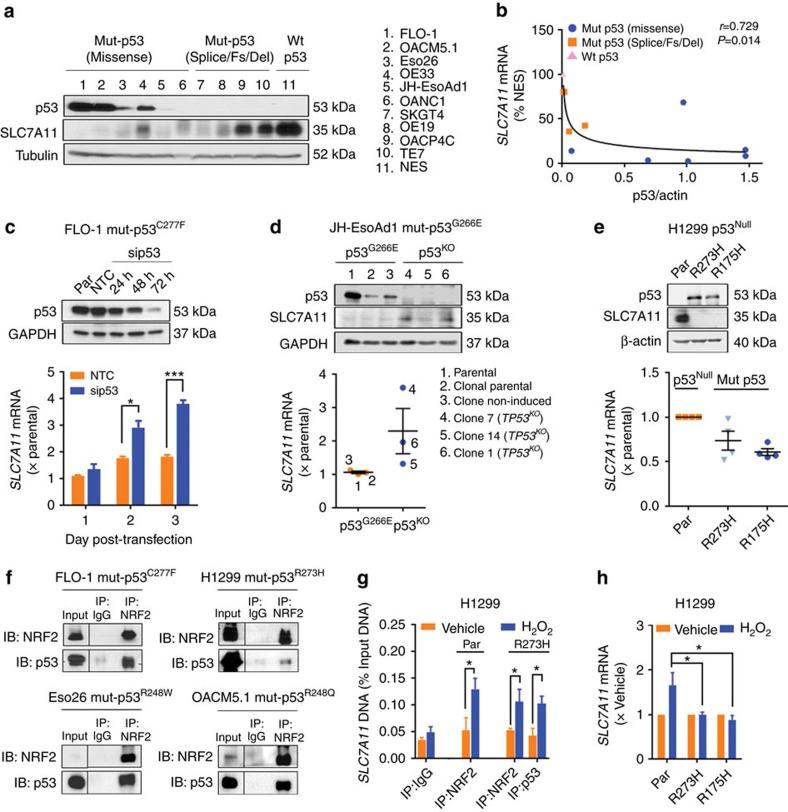
Accumulated mut-p53 entraps NRF2 and represses SLC7A11 expression.(a,b) Correlation between p53 with SLC7A11 protein (a) and mRNA levels (b) in oesophageal cell lines. (c–e) SLC7A11 mRNA (bottom) and protein (top) levels post mut-p53 knockdown (c, non-targeting control (NTC) and p53 siRNA (sip53)) in FLO-1 cells, knockout (d) in JH-EsoAd1 cells and overexpression (e) in H1299 cells. (f) Immunoprecipitation (IP) and immunoblot (IB) of NRF2 with mut-p53 in FLO-1, Eso26, OACM5.1 and H1299 cells under basal growth conditions. Reverse IP and IB in Supplementary Fig. 4. (g) Chromatin IP of the SLC7A11 promoter using NRF2 and mut-p53 antibodies at rest and post H2O2 stress (4 h, 50 μM) in p53Null (Par) and p53R273H H1299 cells. (h) SLC7A11 mRNA expression following vehicle or H2O2 (50 μM) treatment in p53Null (Par), p53R273H and p53R175H H1299 cells. Pearson's correlation (b), unpaired t-test (c,g), one-way ANOVA with Dunnett's multiple comparison post-test (h). Error bars=s.e.m., n=3 for all except (f) n=2, *P<0.05, ***P<0.001. See also Supplementary Fig. 4.